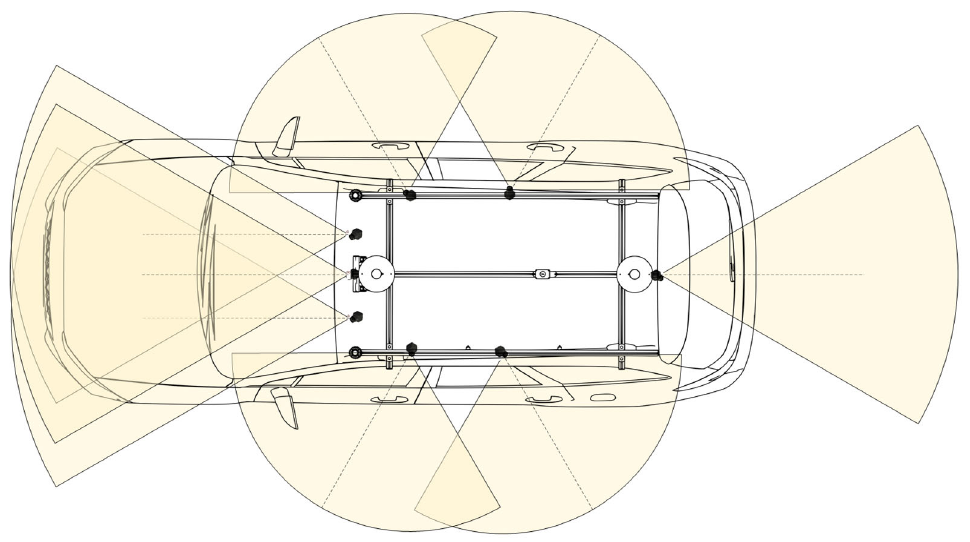
Figure 11. Setup of the eight vehicle cameras on the AFM including their